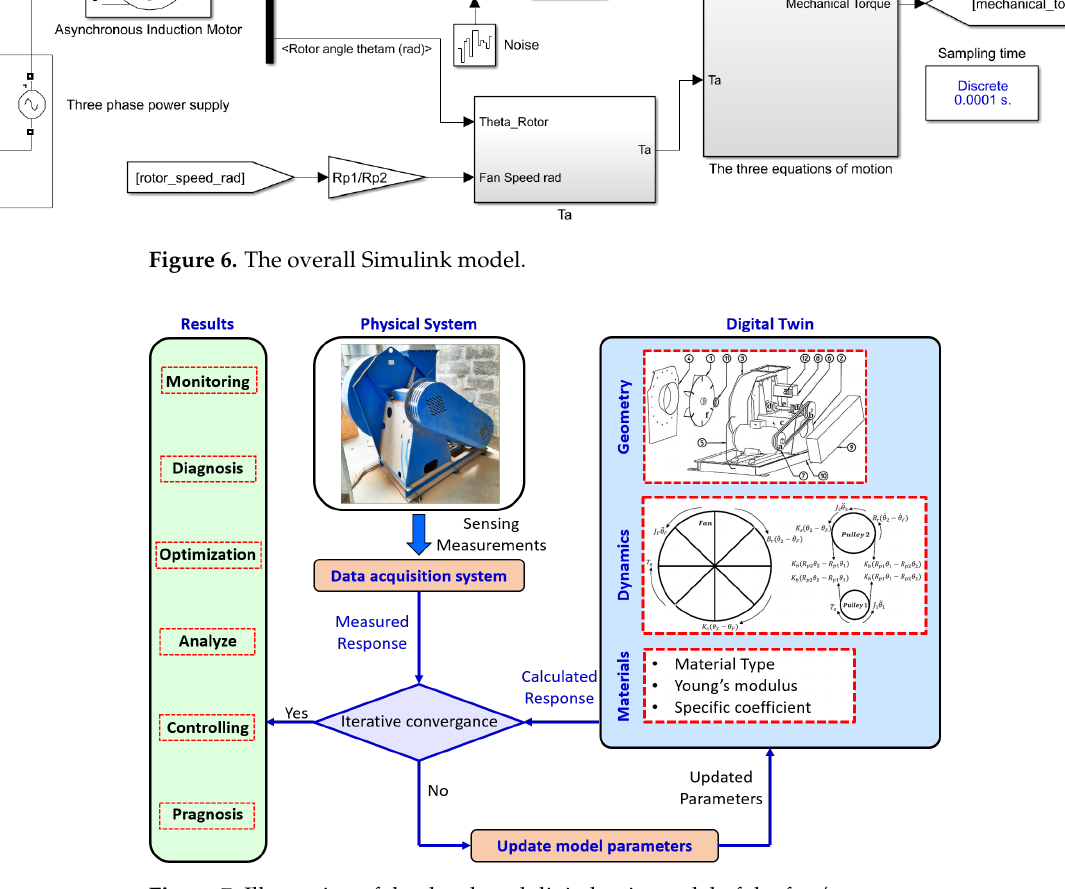
Figure 7. Illustration of the developed digital twin model of the fan/motor